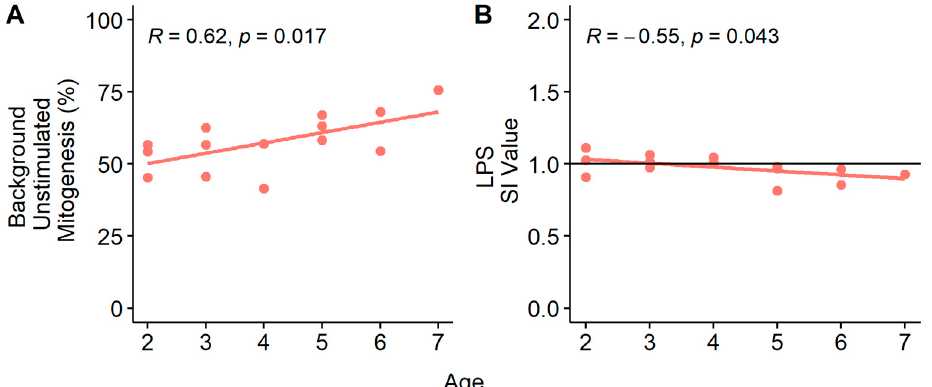
Figure 7. Mitogenesis responses of IgM − lymphocytes relative to age. Data were collected in spring 2019 from smallmouth bass ( Micropterus dolomieu ) sampled at a site on the South Branch of the Potomac River in Moorefield, WV (SB3) for ( A ) unstimulated background mitogenesis and ( B ) LPS stimulated mitogenesis. The horizontal line at 1 represents the stimulation index threshold. Data below this line mean proliferation after stimulation did not exceed the negative controls (unstimulated background mitogenesis).